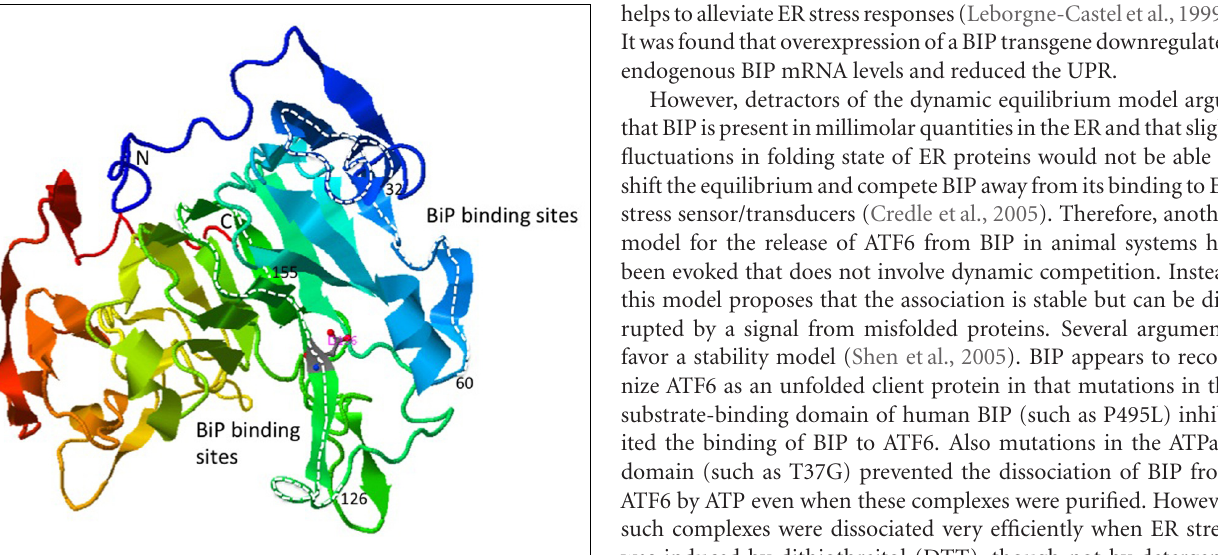
FIGURE 3 | Ribbon structure of the bZIP28 lumenal domain predicted by the template-based prediction program, I-TASSER (Zhang, 2008). The regions of the protein highlighted with the white dashed lines represent the peptides to which BIP preferentially binds in a phage display assay (Srivastava etal.,